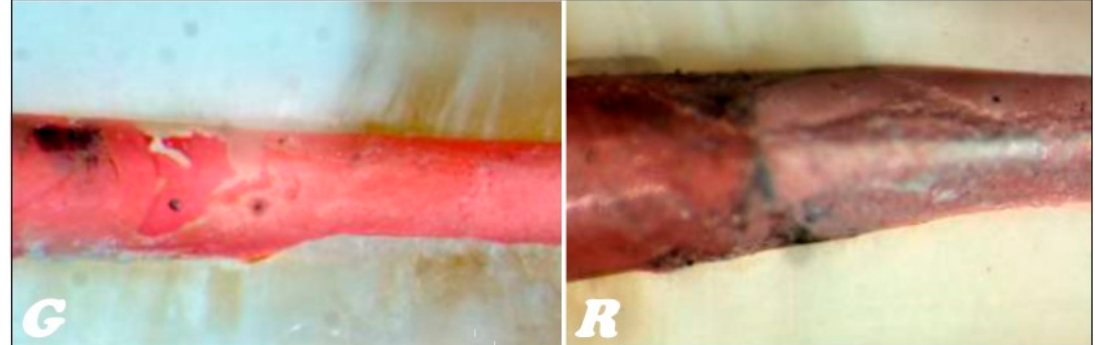
Figure 25. Longitudinal fractures of the teeth filled with hot THC technique in the middle part of the root canal ( G ) with gutta ‐ percha matrix material and ( R ) resilon with a visible linear connection of the main stud with the supplementary material, connected and covered with a thin layer of sealant; LSM.